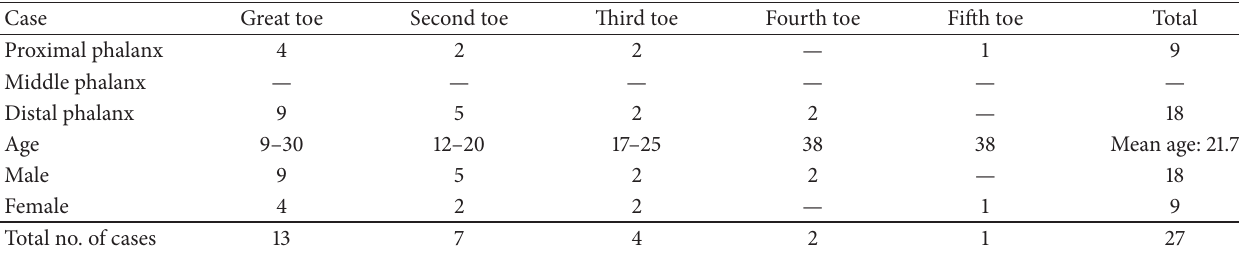
Table 1: Review of the